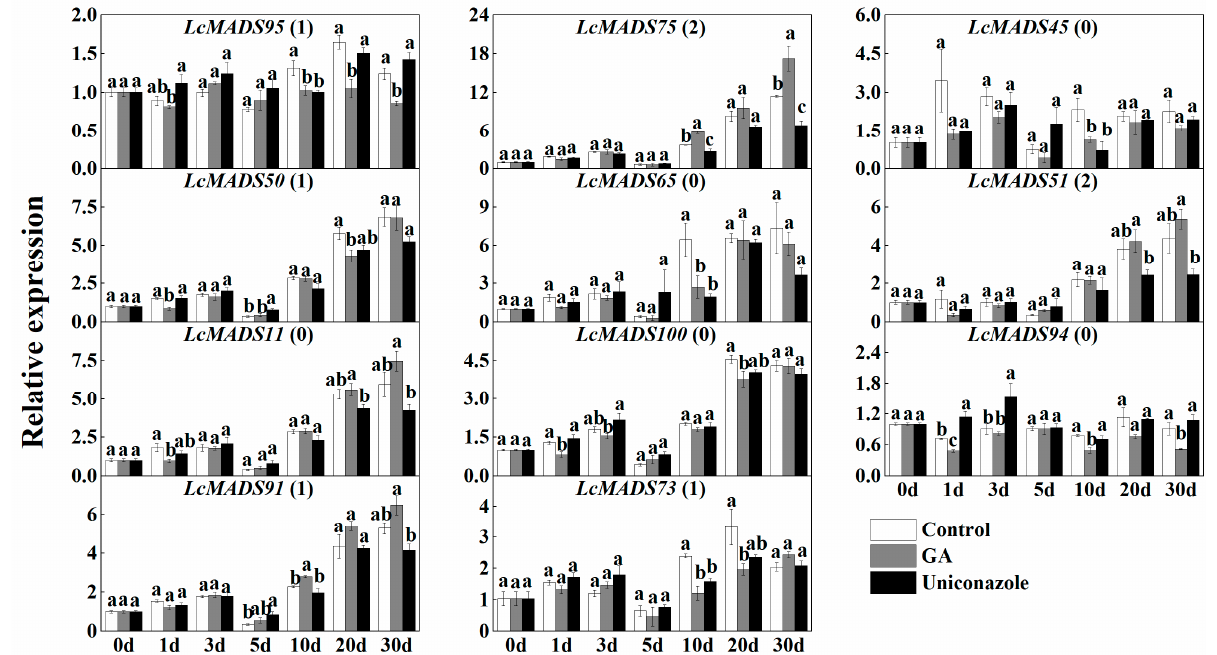
Figure 9. Relative expression of litchi MADS-box genes involved in the ABCDE model in response to treatments of GA or uniconazole. The number following the gene name indicates the number of predicted GA response elements in the promoter region. Data shown are mean ± SE of at least three biological replicates. Differences between treatments at each time point were analyzed by one-way ANOVA with Duncan’s post-hoc test. Significant differences between treatments at each time point are indicated with letters ( p < 0.05).